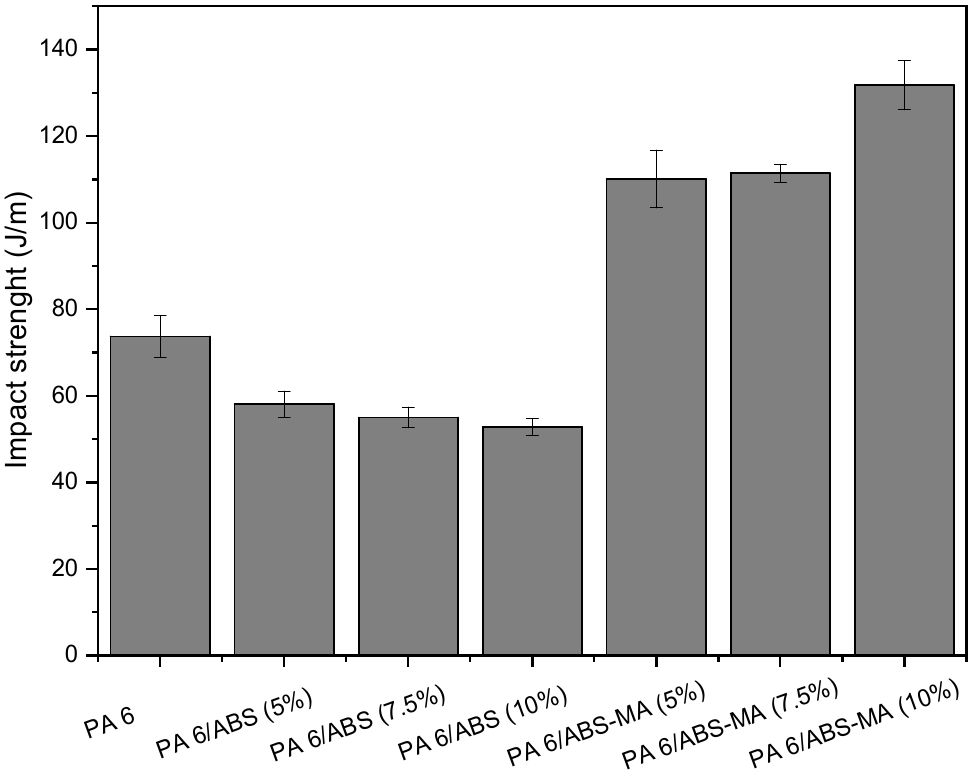
Figure 8. Impact strength of PA6 and binary